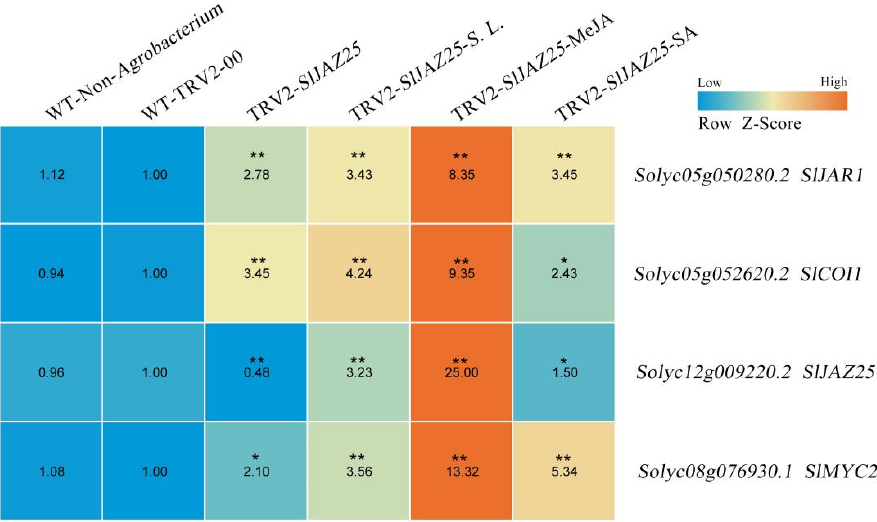
Figure 10. Expression of pathway genes related to SlJAZ25 in the different treatment groups via whole-plant inoculation assays. The mean expression value was calculated from the results of three independent replicates. The number in the boxes indicates the rate of gene expression. A table was plotted after Z-score normalization across each row based on the gene expression data from each gene in the different treatment groups. The colors vary from blue to red, representing the scale of the relative expression levels. Asterisks indicate significant differences (*, p ≤ 0.05; **, p ≤ 0.01) based on Duncan’s multiple range test.